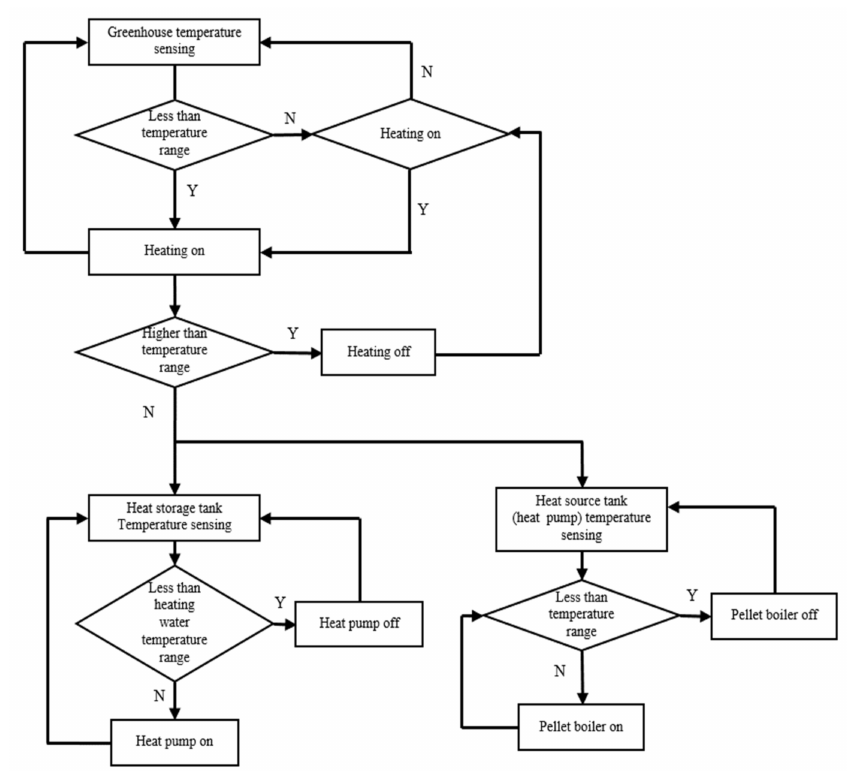
Figure 4. Control logic diagram of hybrid heating